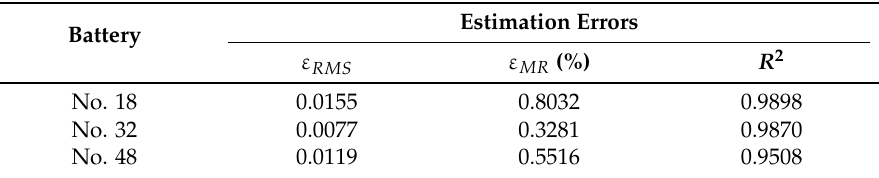
Table 6. Estimation errors of the online estimated capacity.